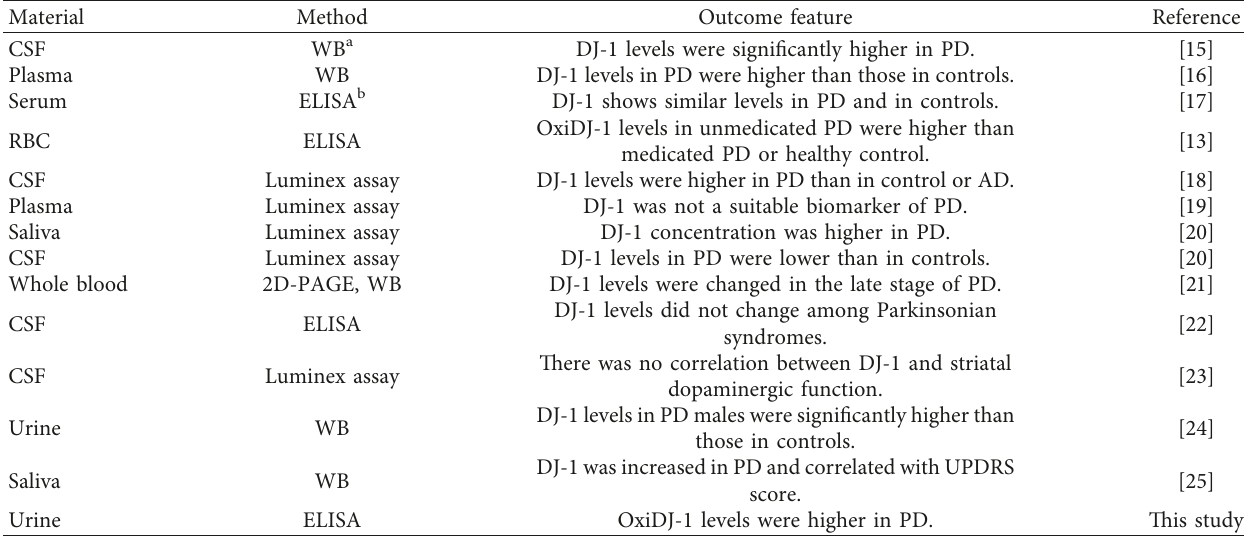
Table 1: Summary of clinical studied examining DJ-1 and OxiDJ-1 as possible biomarkers. Material